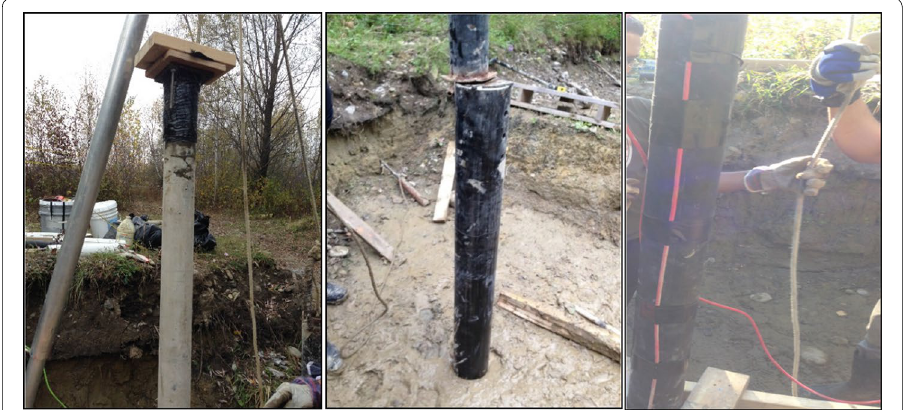
Fig. 1 Model piles (from left to right : precast concrete pile, open-ended steel pile, and closed-end steel